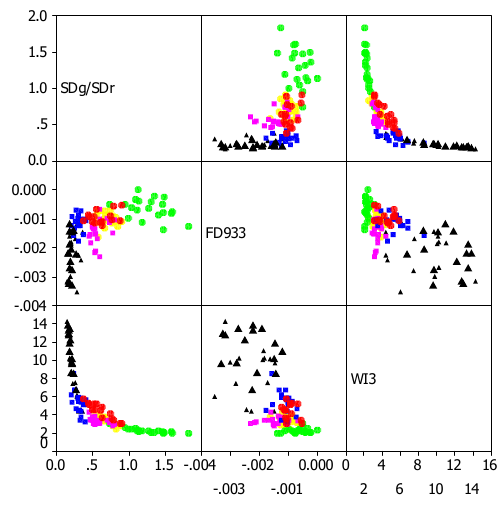
Figure 8. Heavy metal stress level evaluation